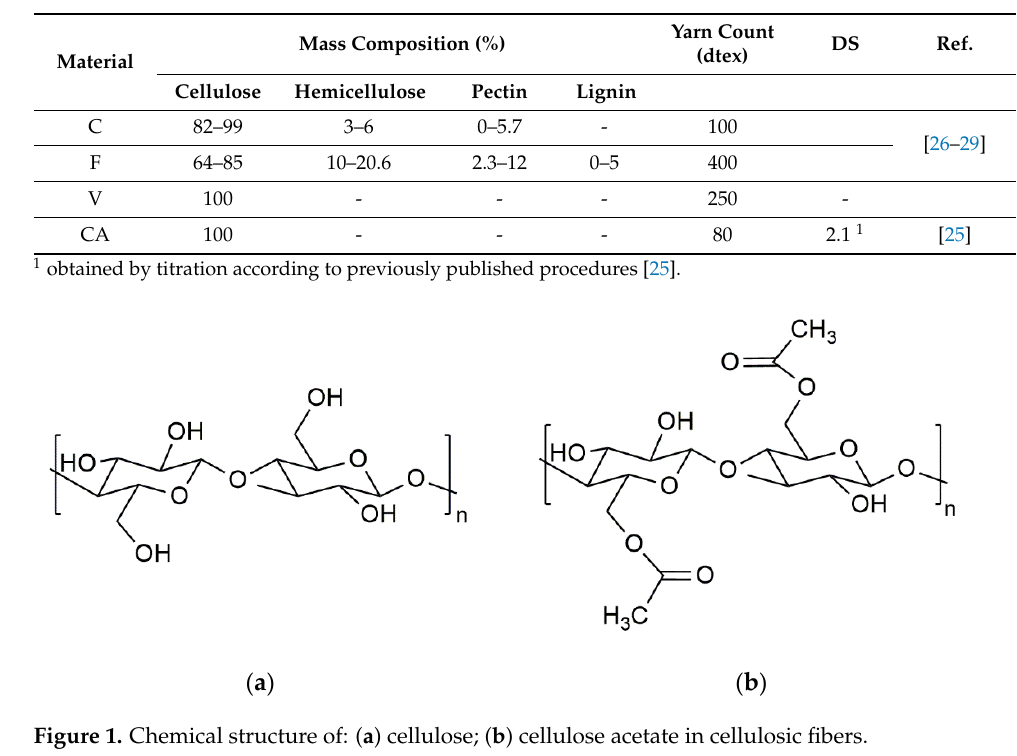
Table 1. Mass percentage of the various constituents of various cellulosic and derivative fibers.